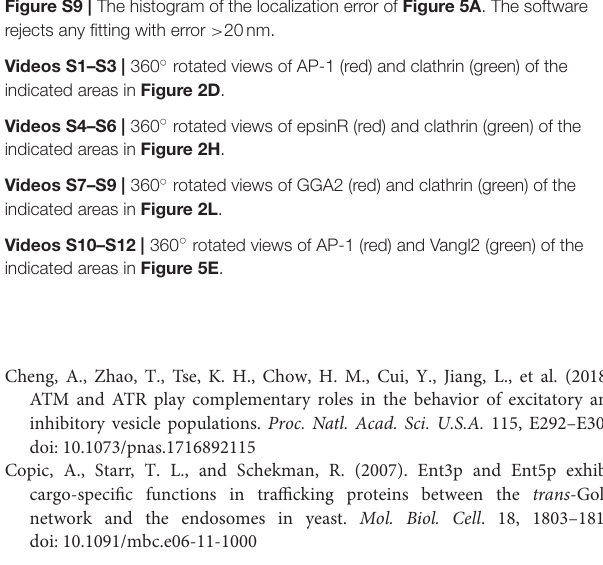
chain were analyzed by STORM. Scale Bar, 500nm. (B–D) Magnified views of the structures highlighted by arrows in (A) . Scale Bar, 100nm. Figure S5 | TGN export of Vangl2 is independent of GGA2. (A–I) HeLa cells were mock transfected (A–C) or transfected with siRNA against clathrin heavy chain (CHC, D–F ) or transfected with siRNA against GGA2 (G–I) and re-transfected after 48h with plasmids encoding HA-Vangl2 (A–I) . On day 3 after knockdown, cells were incubated at 20 ◦ C for 2h then shifted to 32 ◦ C for 50min in the presence of cycloheximide. After incubation, cells were analyzed by immunofluorescence. Scale bar, 10 µ m. (J) Quantification of the percentage of cells showing TGN-accumulated Vangl2 in cells treated with control siRNA or siRNA against CHC or GGA2 after incubation at 32 ◦ C (mean ± SD; N = 3; > 150 cells counted for each experiment). Figure S6 | Knockdown of GGA3 but not GGA1 causes defects in surface delivery of Frizzled6. ( A–L) HeLa cells were mock transfected (A–D) or transfected with siRNA against GGA1 (E–H) or siRNA against GGA3 (I–L) and re-transfected after 48h with plasmids encoding HA-Frizzled6. On day 3 after knockdown, cells were incubated at 20 ◦ C for 2h then shifted to 32 ◦ C for 50min in the presence of cycloheximide. After incubation, cells were analyzed by immunofluorescence. The surface-localized HA-Frizzled6 and the total HA-Frizzled6 were stained by mouse and rabbit anti-HA antibodies, respectively. Scale bar, 10 µ m. (M) HeLa cells were mock transfected or transfected with siRNA against GGA1 or GGA3. On day 3 after transfection, cells were analyzed by immunoblot. (N) Quantification of the percentage of cells showing detectable surface localized Frizzled6 in cells treated with control siRNA or siRNA against GGA1 or GGA3 after incubation at 32 ◦ C (mean ± SD; N = 3; > 100 cells counted for each experiment). ∗∗ p < 0.01 by two-tailed Student’s t -test. Figure S7 | Localizations of Vangl2 and Frizzled6 after temperature shit. (A–F) COS7 cells were transfected with HA-Vangl2 (A–C) or HA-Frizzled6 (D–F) . Day 1 after transfection, cells were incubated at 20 ◦ C for 2h and then at 32 ◦ C for 5min. The localizations of Vangl2, Frizzled6, and TGN46 was then analyzed by immunofluorescence. Scale bar, 10 µ m. Figure S8 | Analysis of the spatial relationships between Vangl2 and Frizzled6 upon exiting the TGN. (A–F) COS7 cells were co-transfected with HA-Frizzled6 and Myc-Vangl2. Day 1 after transfection, cells were incubated at 20 ◦ C for 2h (A–C) or incubated at 20 ◦ C for 2h and then at 32 ◦ C for 5min (D–F) . After incubation, cells were stained with antibodies against HA tag and Myc tag. Two-color STORM was then utilized to visualize localizations of Vangl2 and Frizzled6. (G) Quantification of the percentage of overlapped pixels between Vangl2 and Frizzled6 in cells incubated at 20 ◦ C for 2h or in cells incubated at 20 ◦ C for 2h and then at 32 ◦ C for 5min (mean ± SD, based on three super-resolution images each). ∗∗∗ p < 0.001 by two-tailed Student’s t -test. Figure S9 | The histogram of the localization error of Figure 5A . The software rejects any fitting with error > 20nm. Videos S1–S3 | 360 ◦ rotated views of AP-1 (red) and clathrin (green) of the indicated areas in Figure 2D . Videos S4–S6 | 360 ◦ rotated views of epsinR (red) and clathrin (green) of the indicated areas in Figure 2H . Videos S7–S9 | 360 ◦ rotated views of GGA2 (red) and clathrin (green) of the indicated areas in Figure 2L . Videos S10–S12 | 360 ◦ rotated views of AP-1 (red) and Vangl2 (green) of the indicated areas in Figure 5E